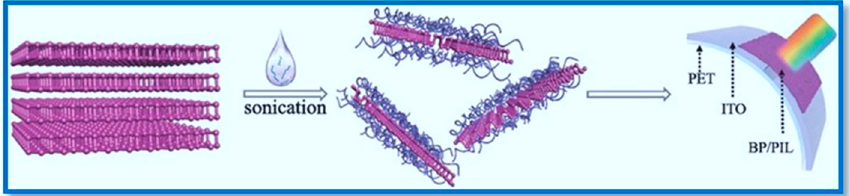
Figure 15. Schematic illustration of the exfoliation of BP assisted by diluted polymer ionic liquid (PIL) solution. The PIL-modified few-layer BP nanosheets were then used in the active layer of the flexible photodetector. Copyright 2018, WILEY-VCH Verlag GmbH & Co. KGaA, Weinheim, Reproduced with permission from Adv. Funct. Mater. [133], Copyright 2018, WILEY-VCH Verlag GmbH & Co. KGaA.